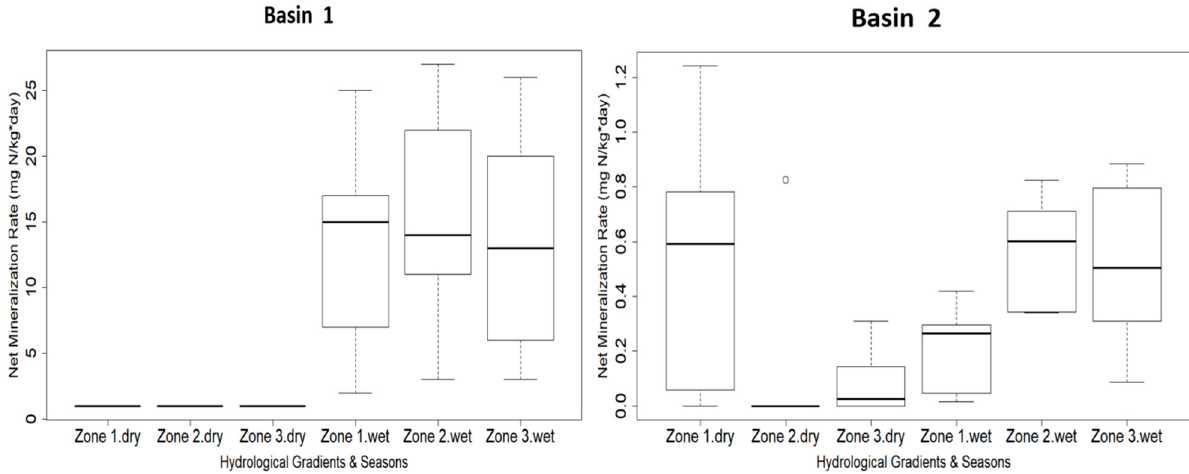
Figure 3. Net N mineralization rates of SIB soils by zones and seasons. Zone 1, frequently flooded; Zone 2, ocassionally flooded; Zone 3, rarely flooded. Values represent data from the entire soil profile (all three sampling depths).